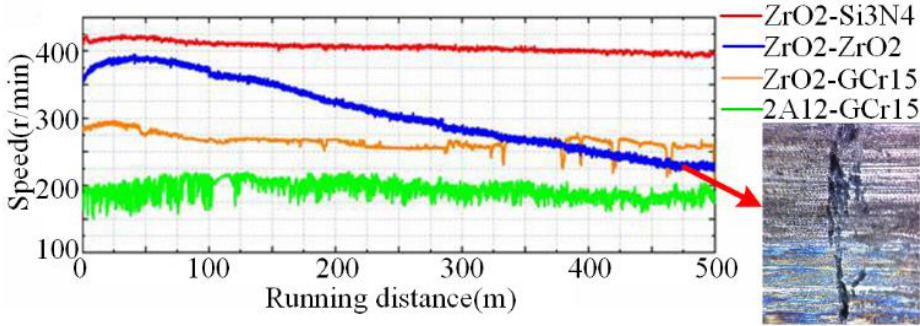
Figure 5. Output speed stability experiment under long-term operation (500 m).